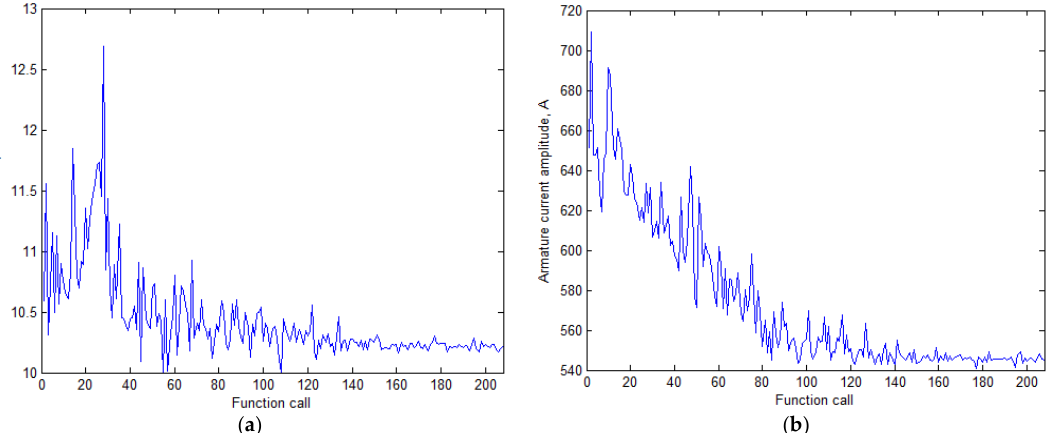
Figure 6. Change of the motor parameters during optimization. ( a ) Average losses; ( b ) maximum magnitude of the power winding current.